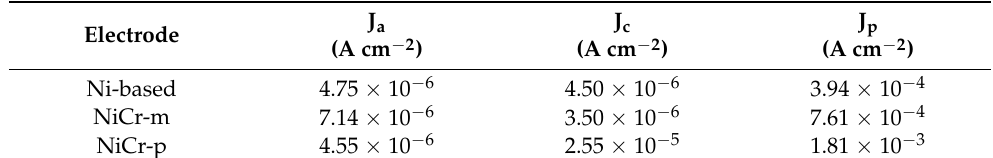
Table 3. The values of the current densities.